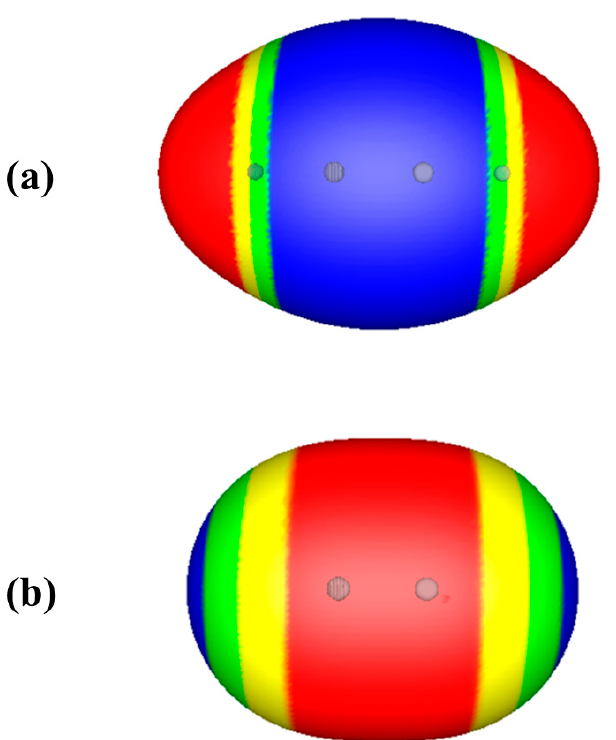
Figure 2. Computed electrostatic potentials on 0.001 au surfaces of ( a ) acetylene, HC ≡ CH, and ( b ) nitrogen, N ≡ N. Circles indicate positions of nuclei. Color ranges, in kcal/mol, are—red, more positive than 4; yellow, between 4 and zero; green, between zero and − 4; blue, more negative than − 4.